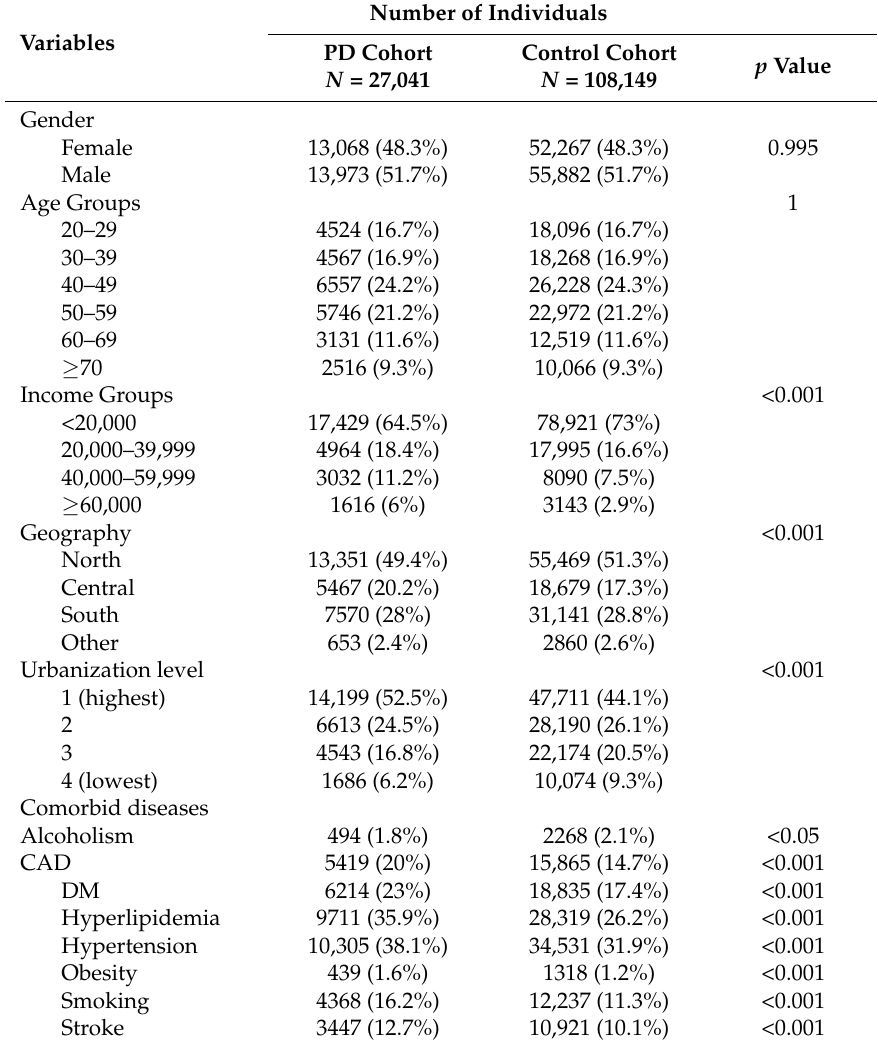
Table 1. Distribution of gender, age groups and comorbidities in individuals with and without periodontal disease (PD).